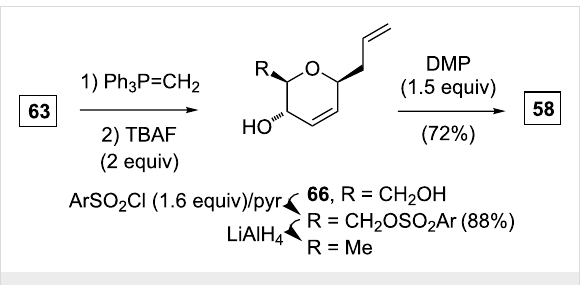
Scheme 9: Alternative synthesis of the dihydro-3-pyrone 58